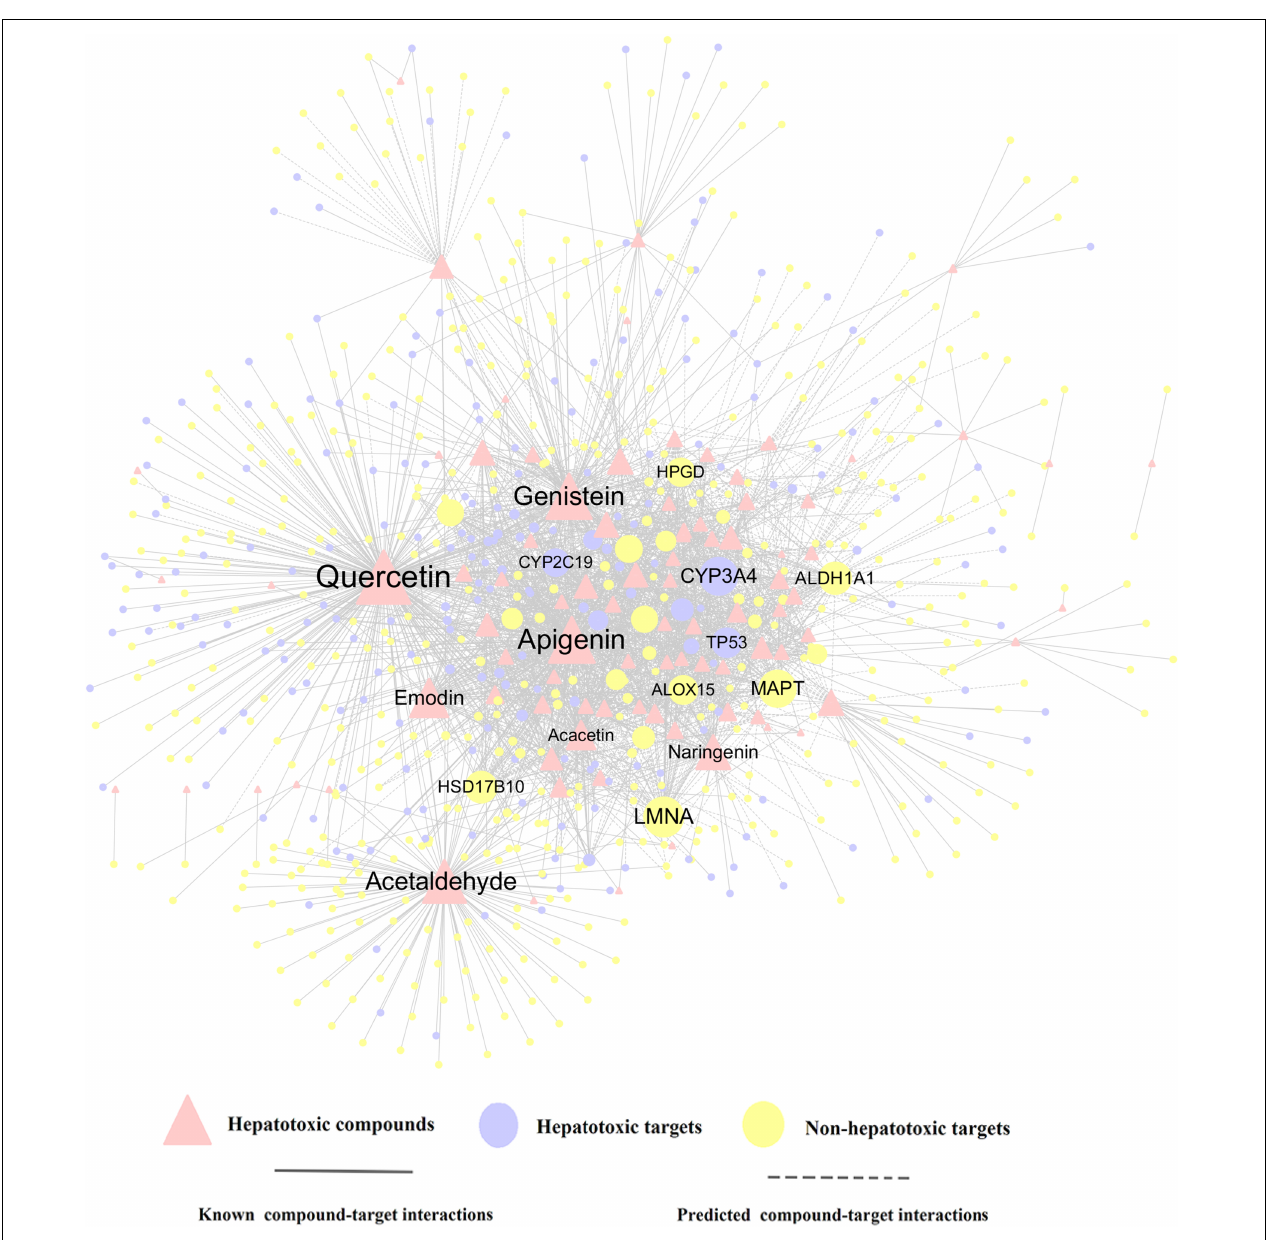
FIGURE 5 | A compound-target (C-T) network consists of 1,056 known interactions as well as 1,245 predicted interactions, including 91 compounds, 211 hepatotoxic targets and 464 non-hepatotoxic targets. The label font size and node size are proportional to degree.